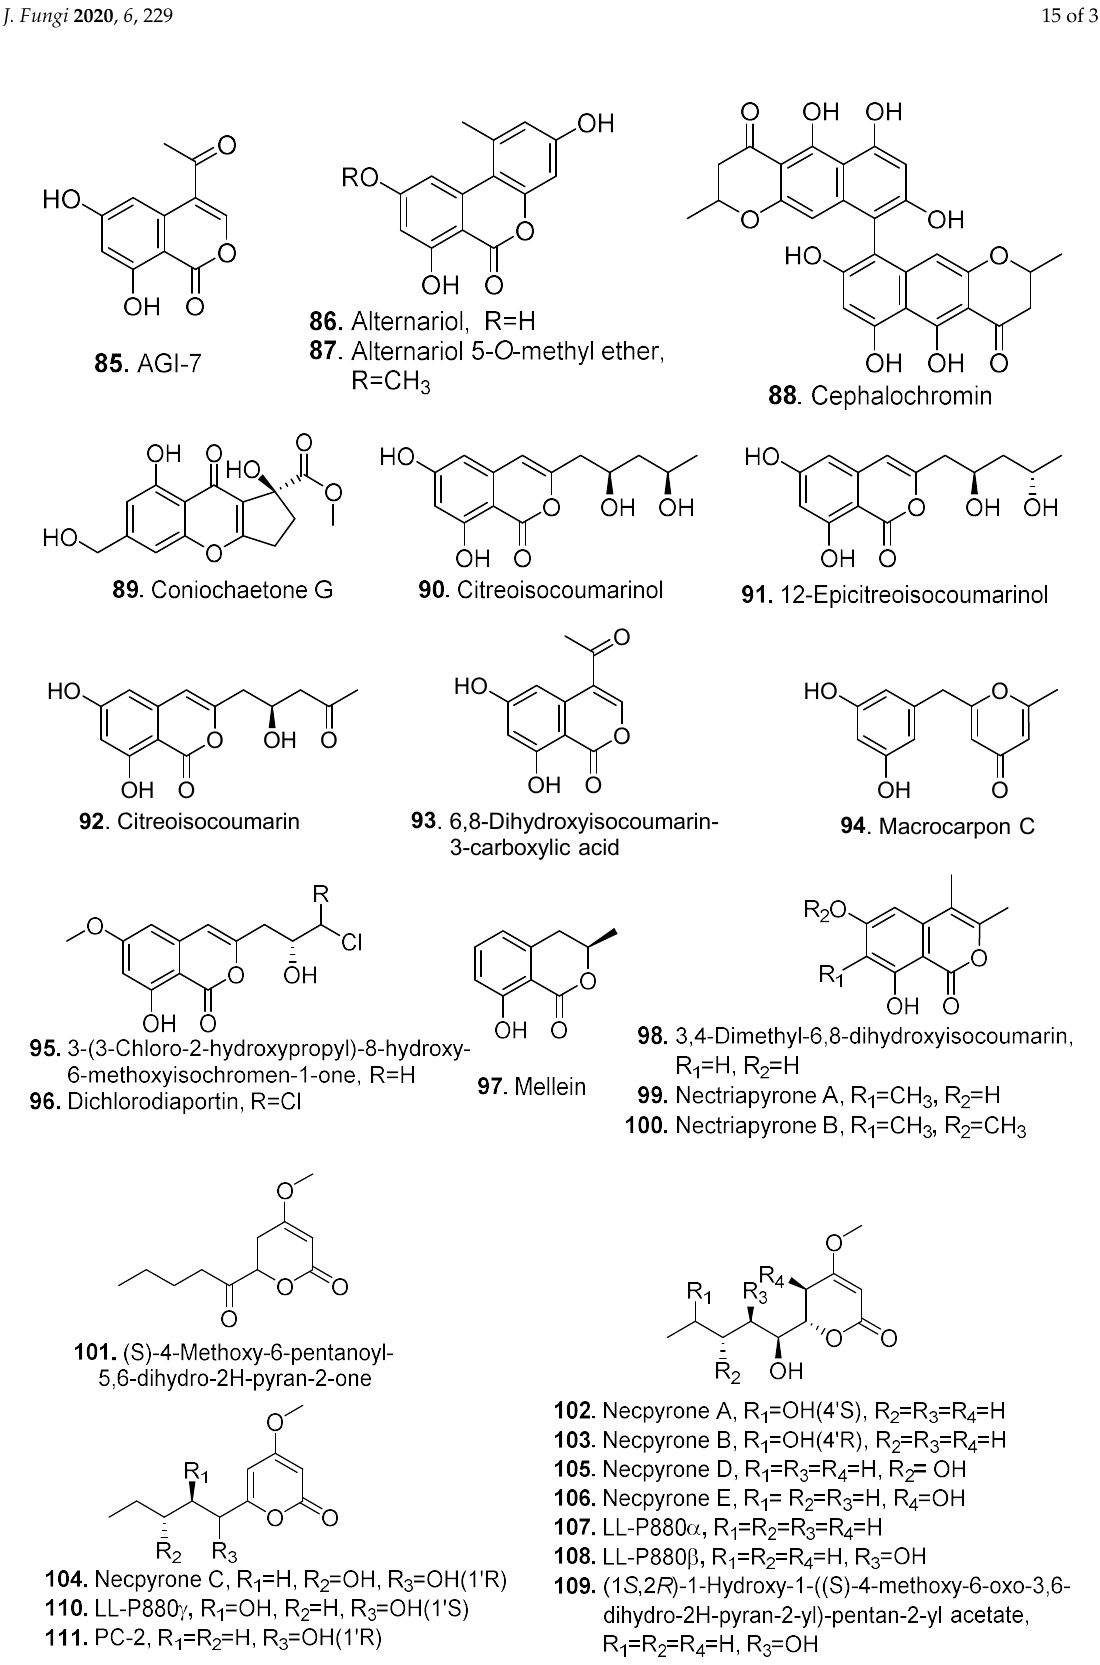
Figure 5. Pyranones isolated from Clonostachys fungi.